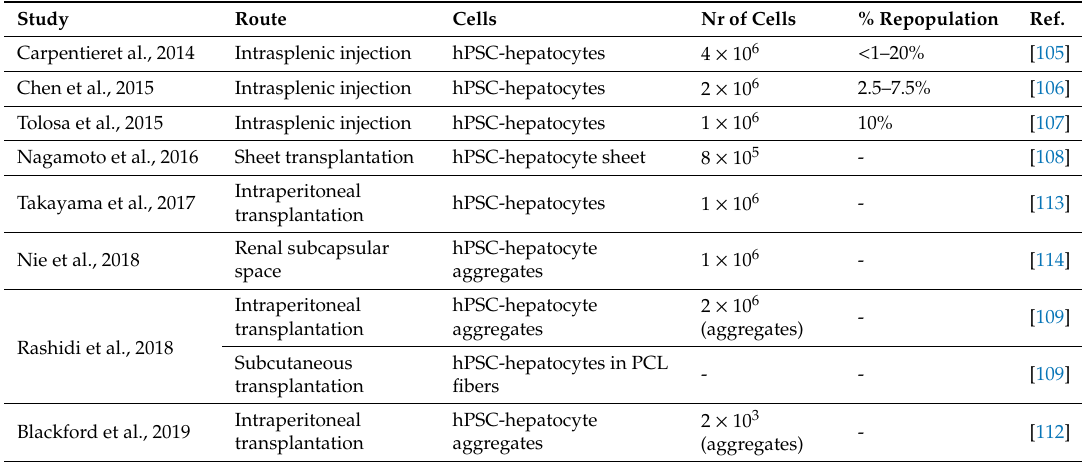
Table 2. Summary of recent studies on hPSC-derived hepatocyte transplantation in murine models. Study Route Cells Nr of Cells % Repopulation